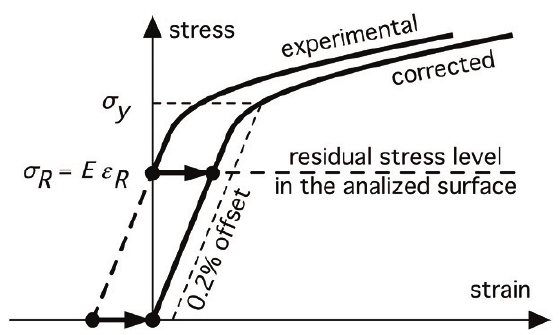
Figure 1. Correction of the stress-strain curve due to the presence Figure 1 - Correction of the stress-strain curve due to the presence of residual stresses and 0.2% of residual stresses and 0.2% offset yield strength ( σ y ) offset yield strength ( σ ) determination. y